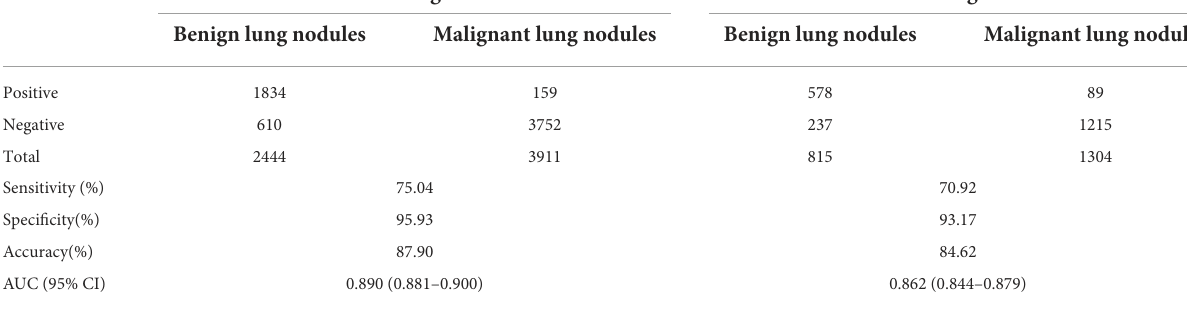
TABLE 5 Results of the proposed model to distinguish between benign and malignant lung